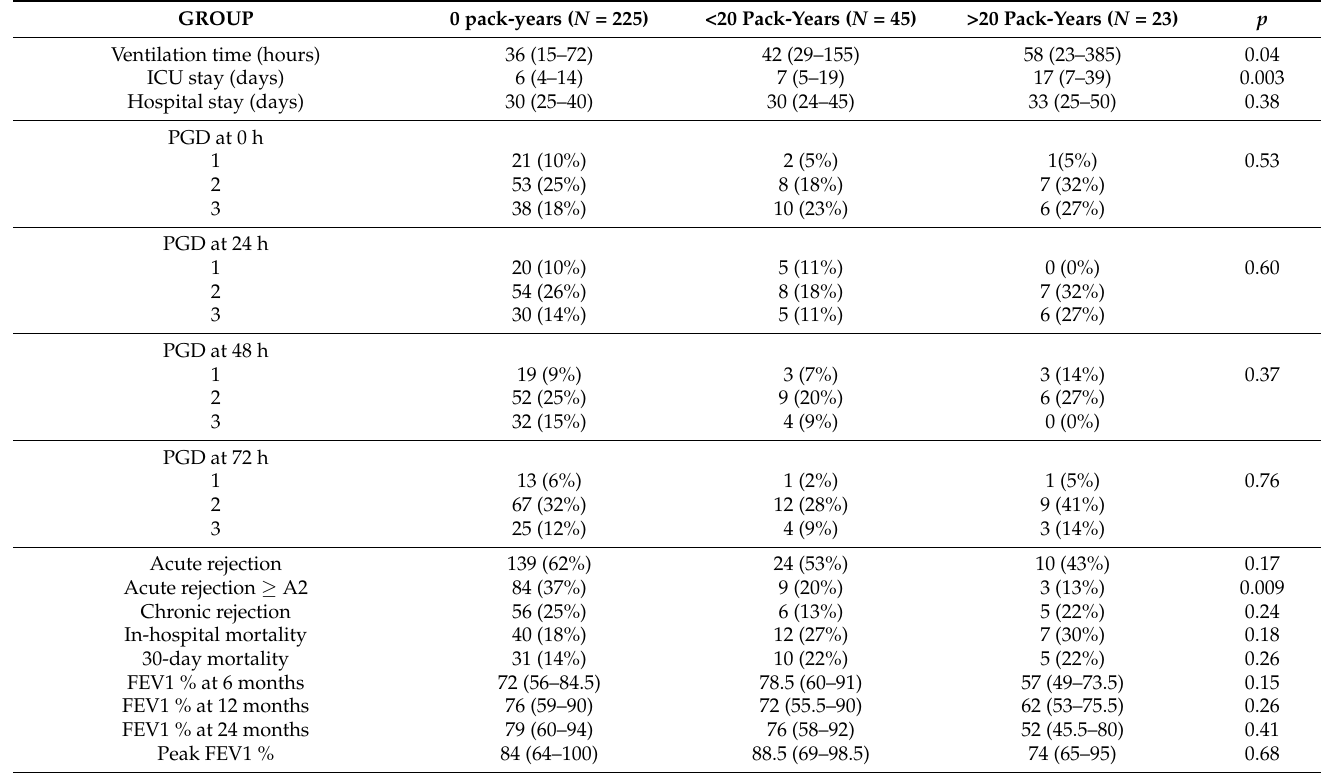
Table 2. Early- and mid-term post-operative outcomes 1